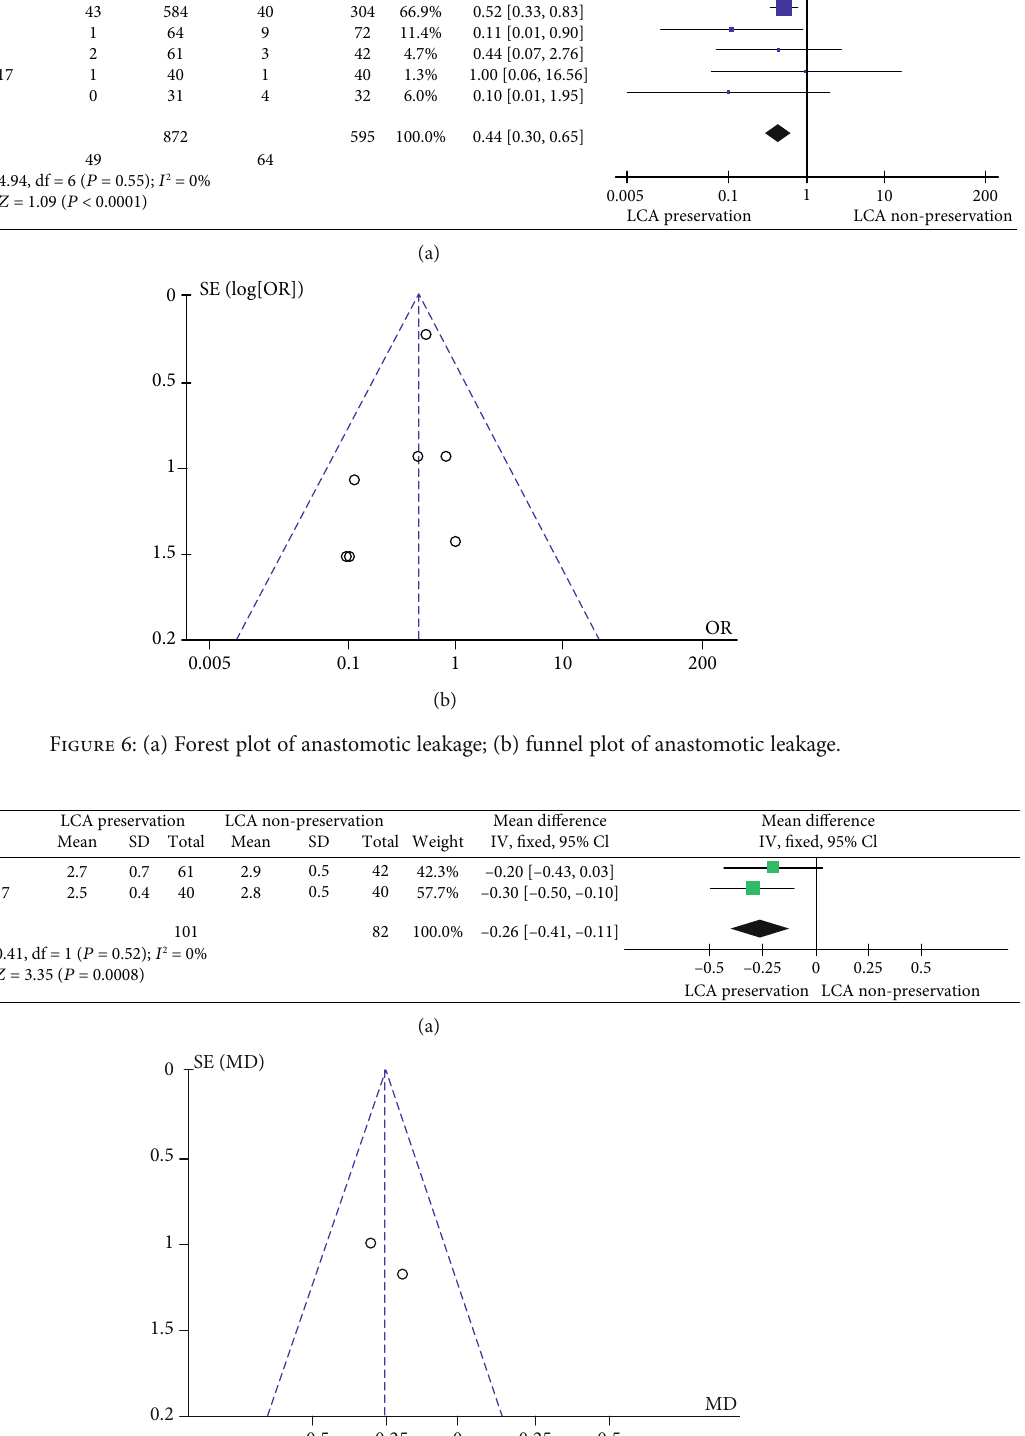
0.0001)Total Heterogeneity: Chi 2 = 4.94, df = 6 ( P = 0.55); I 2 = 0% Test for overall effect: Z = 1.09 ( P <